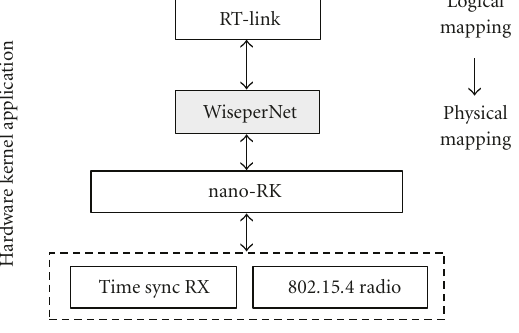
Figure 20: WisperNet application layer.